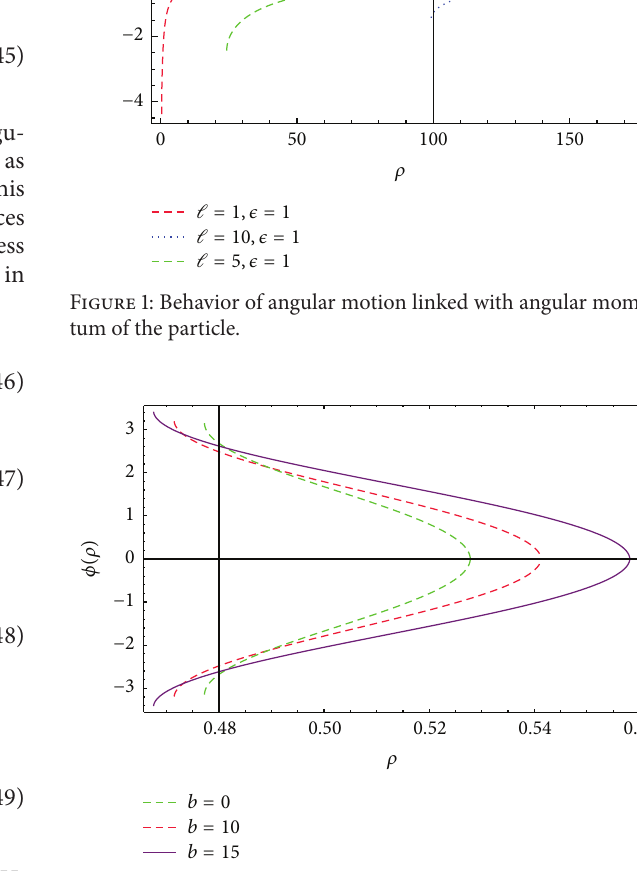
Figure 2: Effect of magnetic field on the charged moving particle, for E = 1 , ℓ = 10